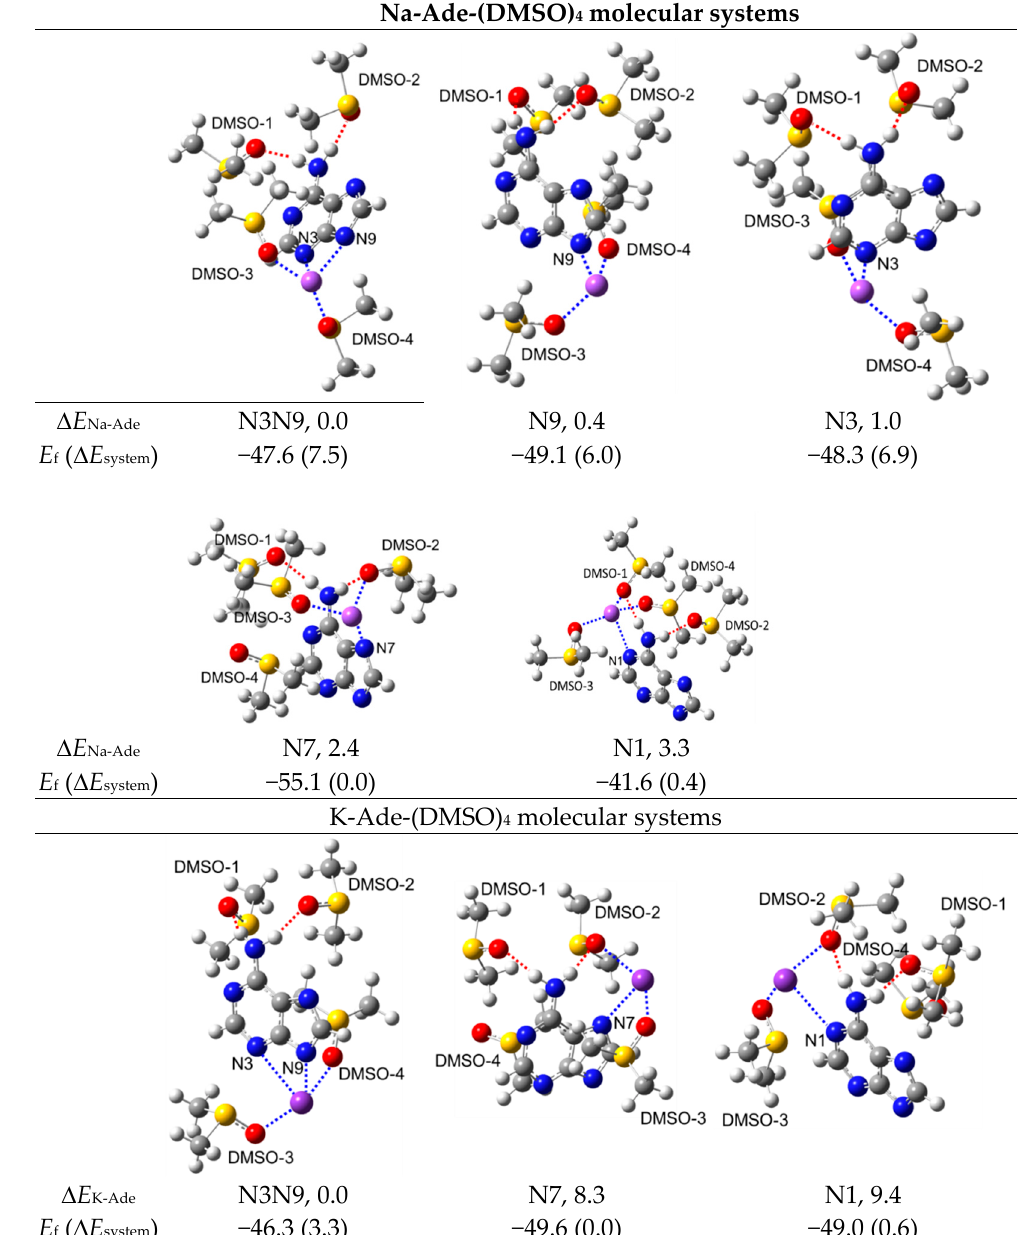
Figure 2. The DFT-optimized structures of the indicated in-plane Na- and K-Ade-(DMSO) 4 systems and, relative to the lowest energy N-CIP, the energy difference, Δ E Na-Ade , between Na-Ade complexes solvated by four DMSO molecules. The energy of formation ( E f ) of the Na- and K-Ade-(DMSO) 4 molecular systems and, relative to the lowest energy system, the electronic energy difference between entire molecular systems ( Δ E system ) are also provided. All values are in kcal mol − 1 . Somewhat larger energy differences were found for K-Ade complexes, whereby the N7- and N1-CIP were 8.3 and 9.4 kcal mol − 1 higher in energy than the N3N9-CIP.